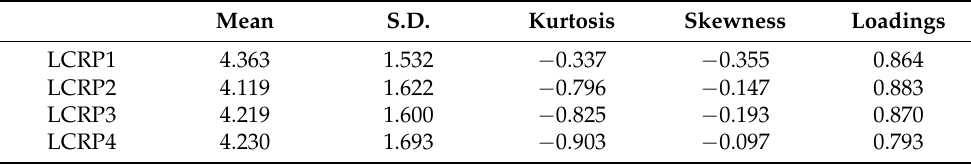
Table 3. Descriptive statistics and factor